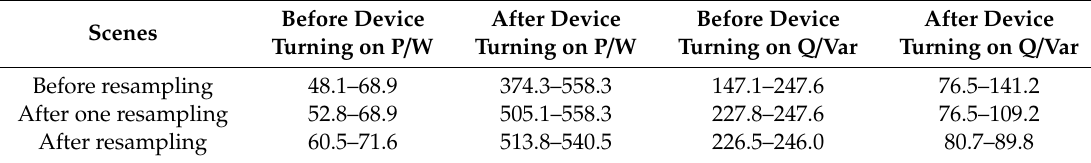
Figure 7. Air-conditioning resampling process: ( a ) particles before resampling (before change point); ( b ) particles before resampling (after change point); ( c ) particles after one resampling (before change point); ( d ) particles after one resampling (after change point); ( e ) particles after resampling (before change point); and ( f ) particles after resampling (after change point). Table 5. Air conditioning load switching and resampling results.